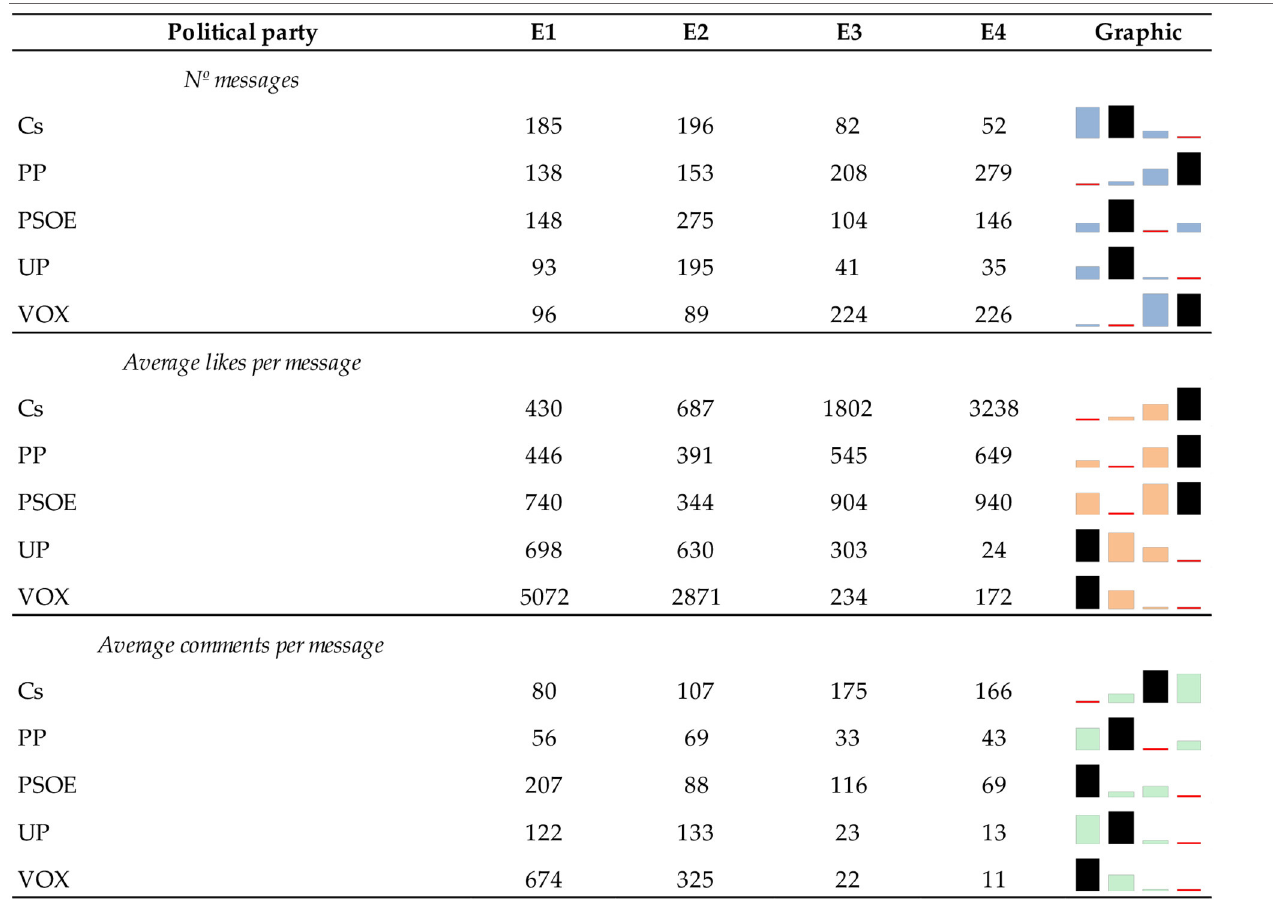
TABLE 5 | General communication profiles of political parties during the General Elections (2015–2019).